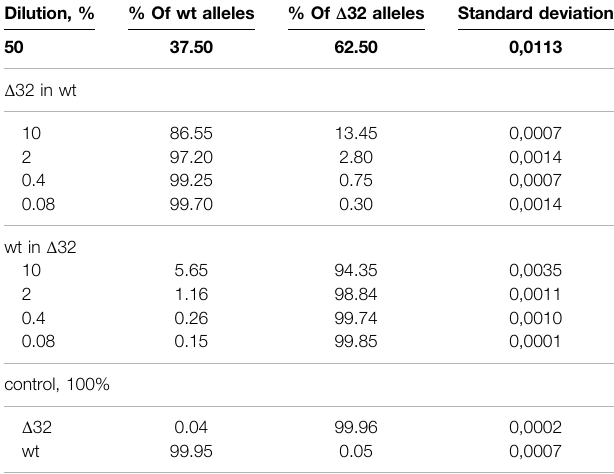
TABLE 1 | Detection of the ratios of CCR5 Δ 32 mutant and wild-type alleles by ddPCR using heterogeneous cell mixture dilution. Dilution, % % Of wt alleles % Of Δ 32 alleles Standard